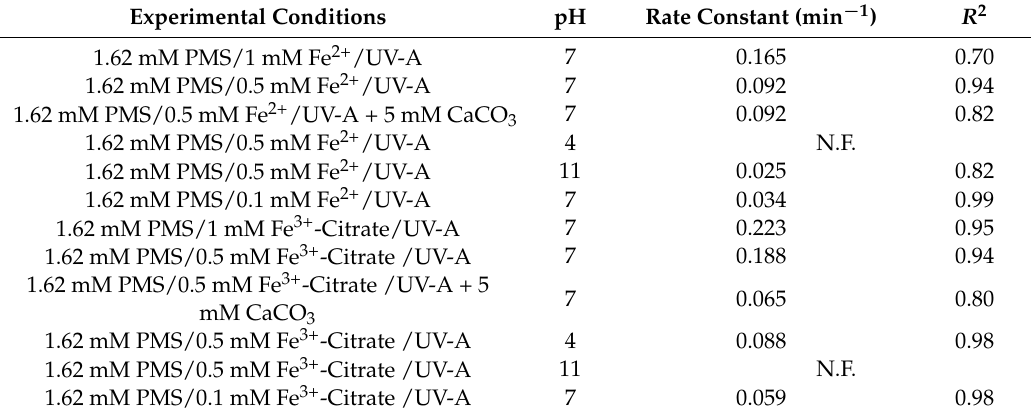
Figure 3. Influence of the PMS:Fe ratio (1.62:1; 3.25:1 and 16.1:1 of PMS:Fe 2+ ), pH (4, 7 and 11) and the presence of scavenger substances (5 mM CaCO 3 ), in MB discolouration through PMS photocatalytic activation with Fe 2+ and UV-A radiation. Table 2. Pseudo-first-order kinetic rates (min − 1 ) for the photocatalytic activation of PMS with Fe 2+ and Fe 3+ -citrate under different operating